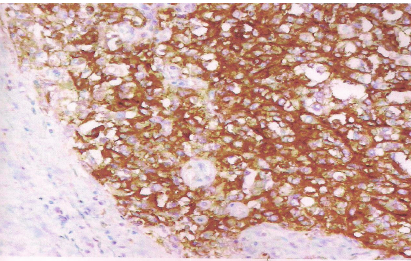
Figure 4: Metastatic vertebral osteolysis spondyle and the spinous process of the twelfth thoracic